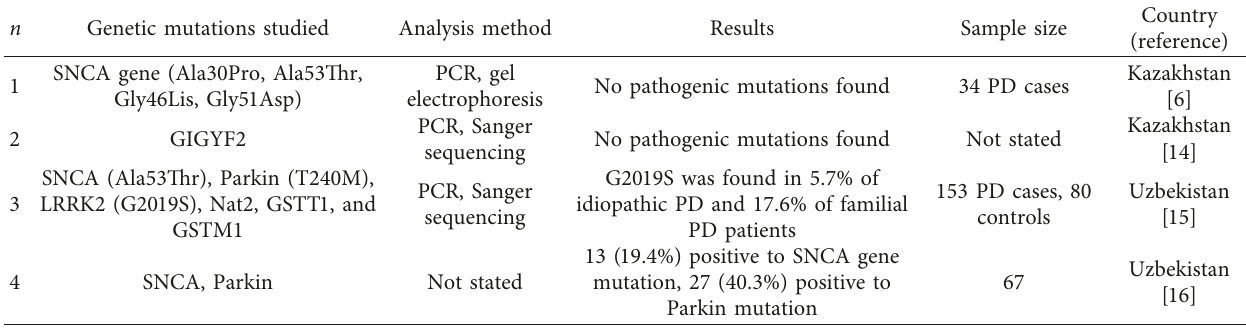
Table 2: PD genetic studies in Central Asian